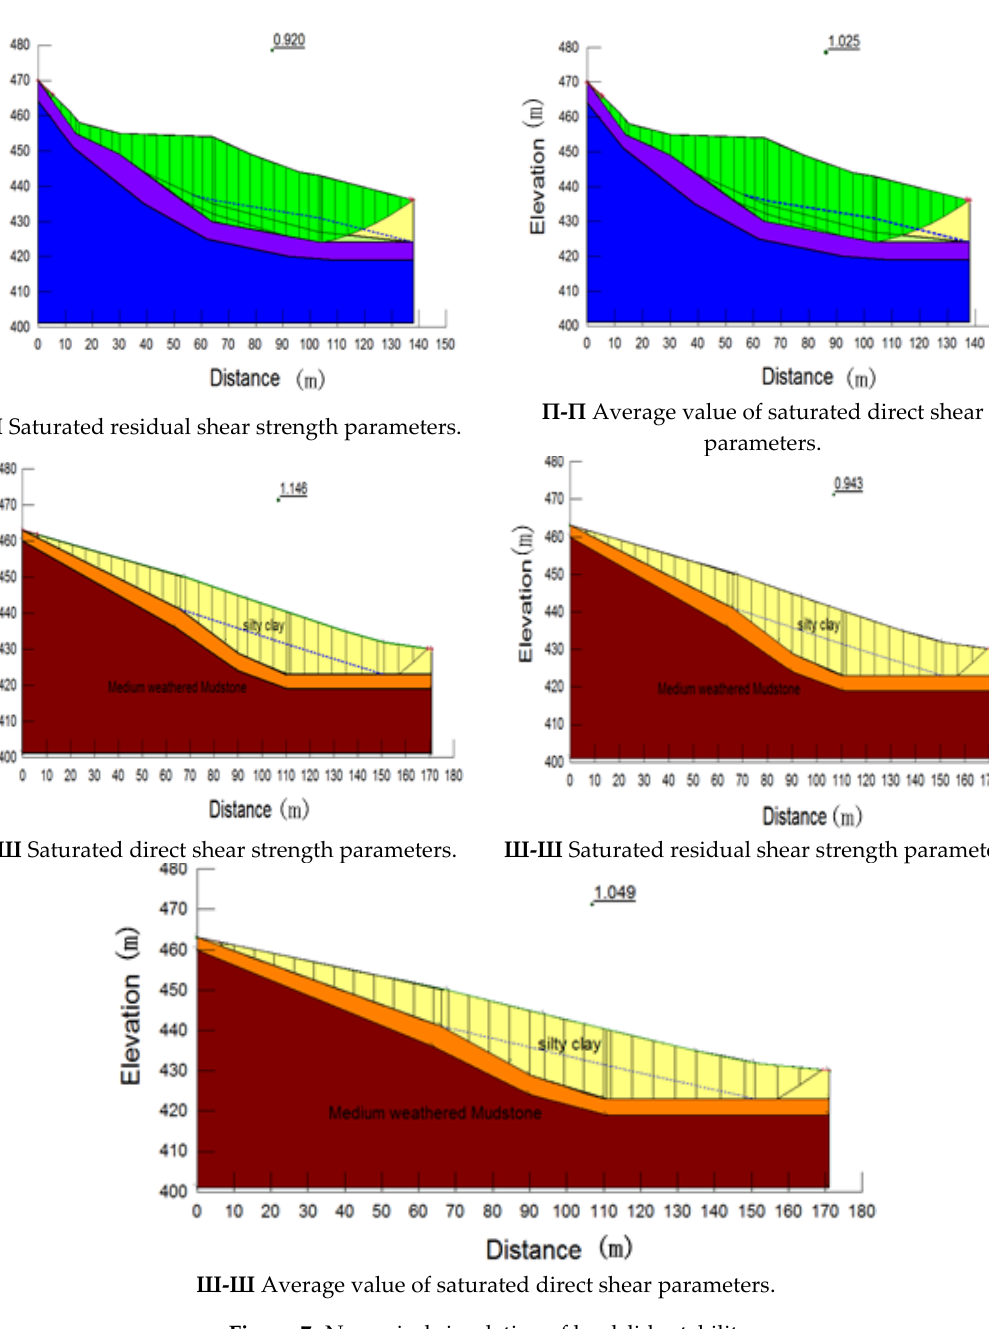
Figure 7. Numerical simulation of landslide stability.